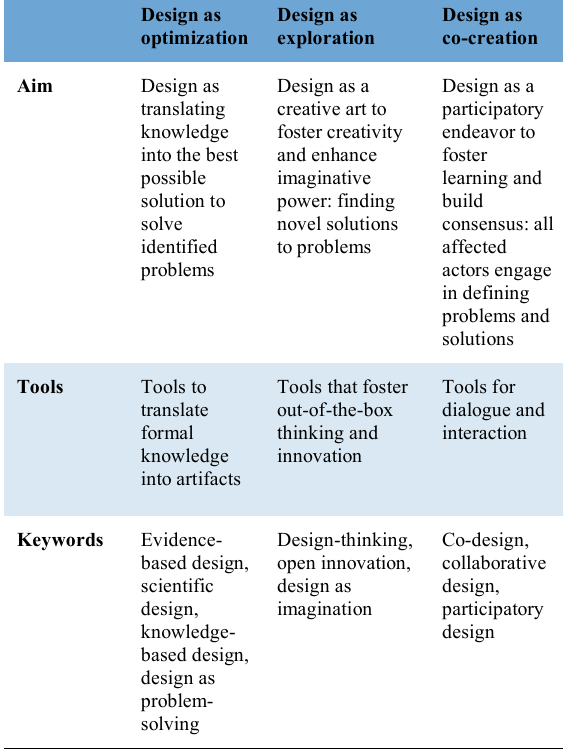
Table 1. Design approaches in policy design – table adapted from Van Buuren et al.